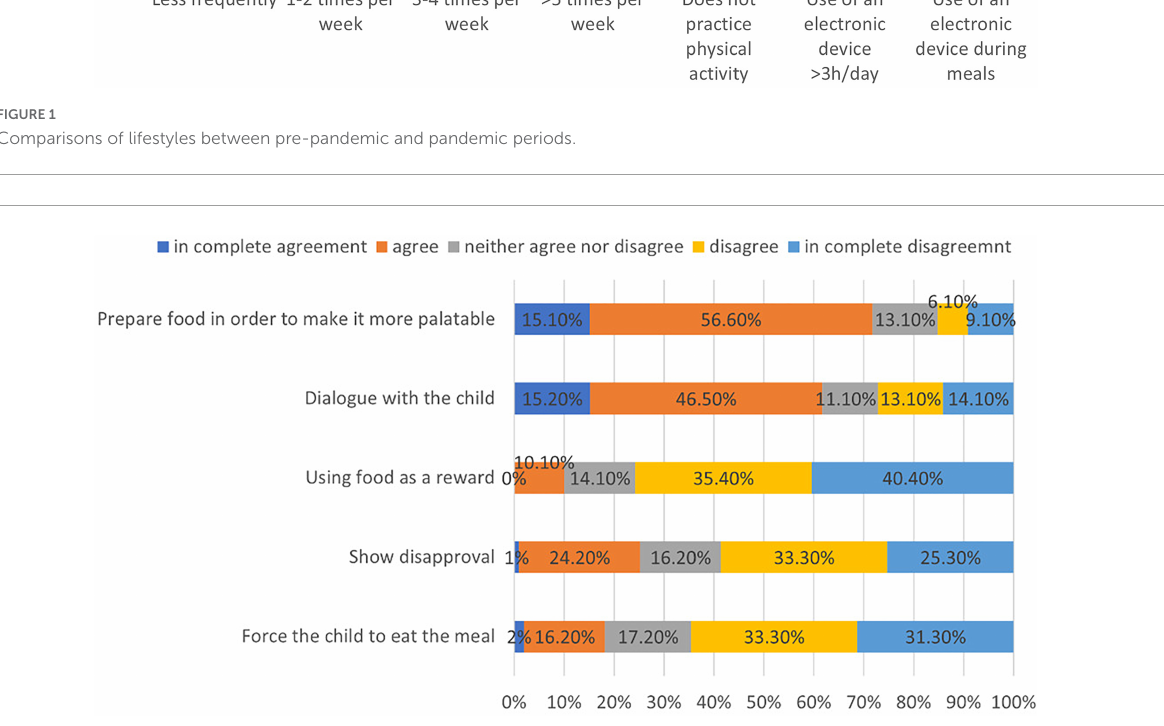
FIGURE2 Educational strategies adopted in case of food